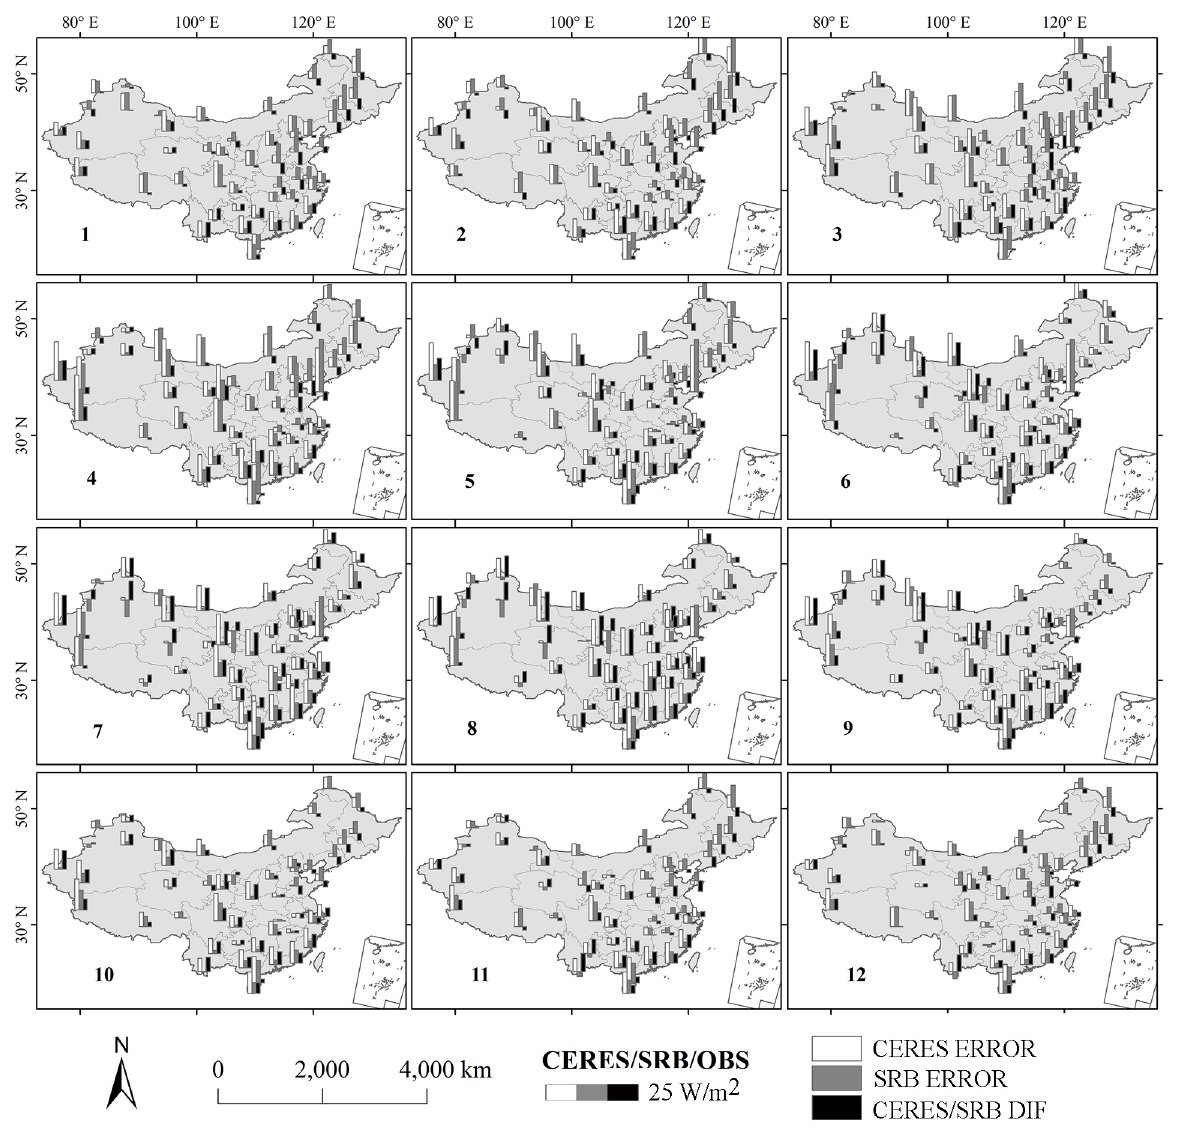
Figure 5. Spatial distribution of multi-year averaged errors in monthly surface net radiation generated from the CERES and SRB